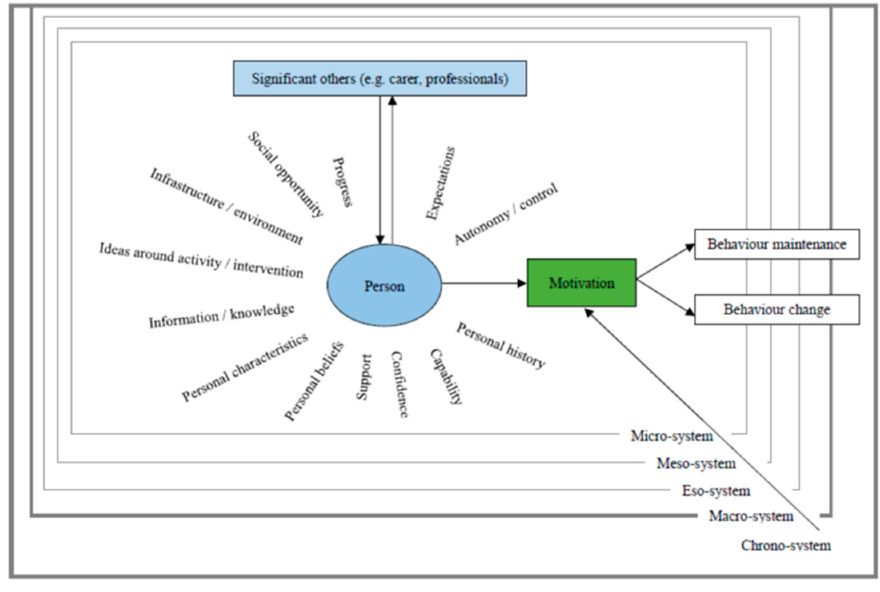
Figure 3. Proposed revision of the PHYT-in-dementia.